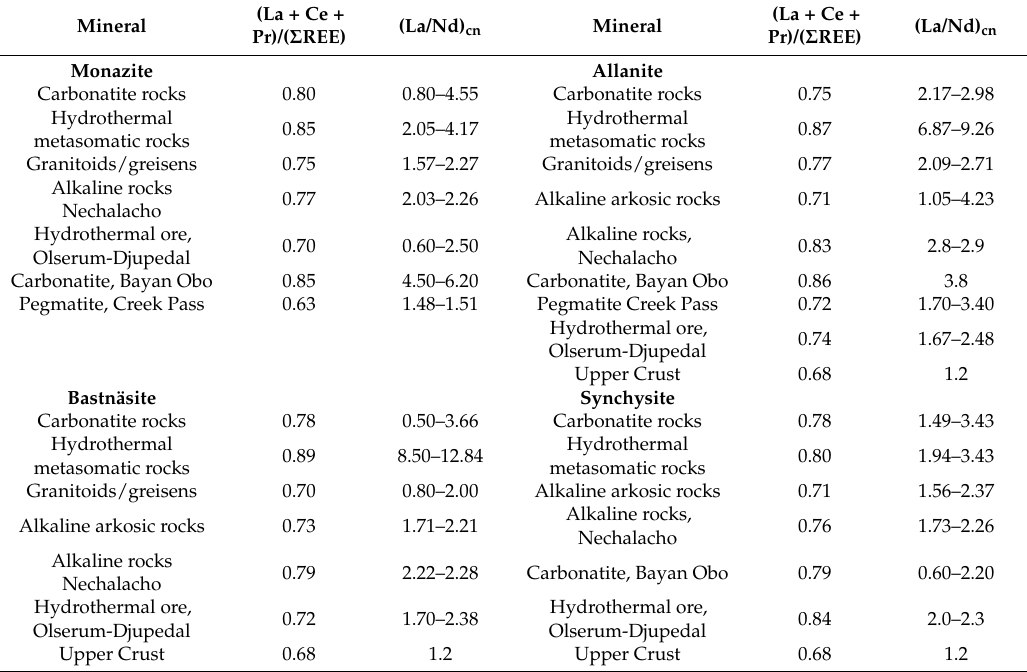
Table 2. The ratios of (La/Nd) cn and (La + Ce + Pr)/( Σ REE) in REE minerals from the studied areas compared to measured ratios from other world’s REE